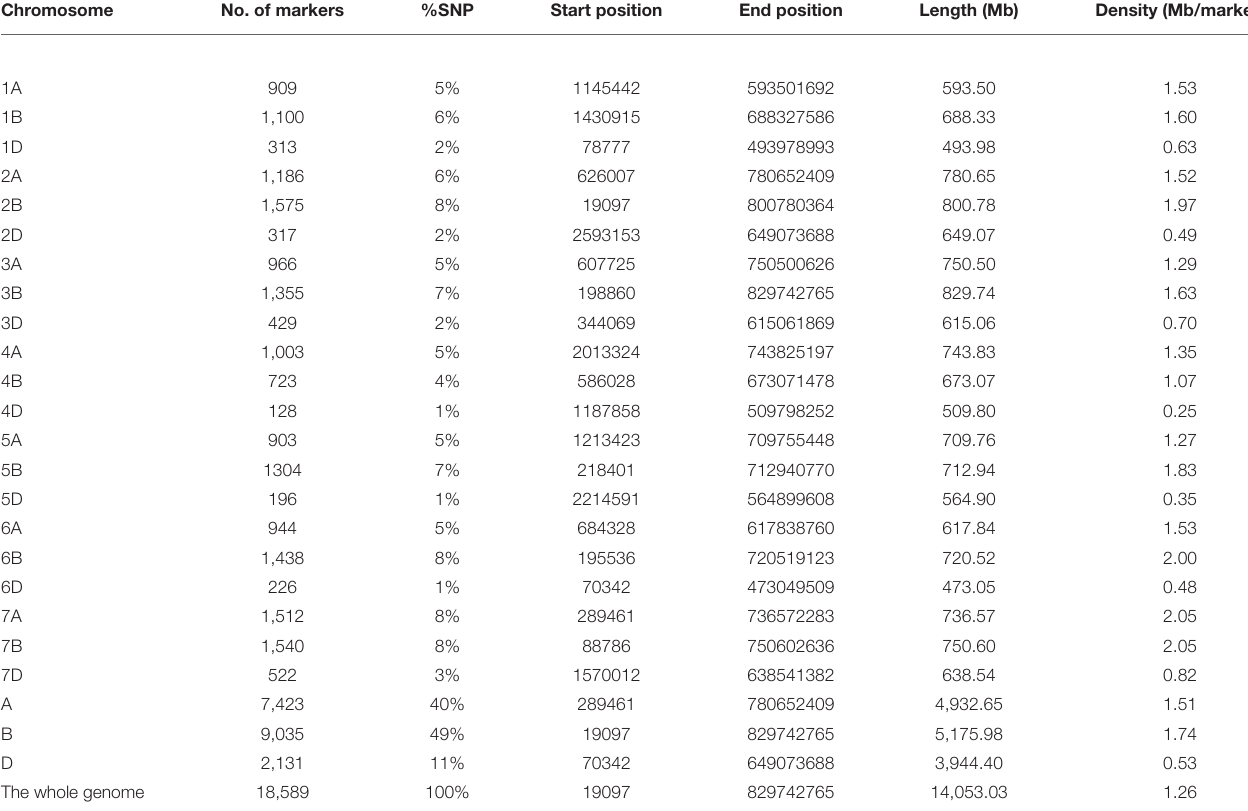
TABLE 1 | The summary statistics of GBS-SNPs across chromosomes and genomes. Chromosome